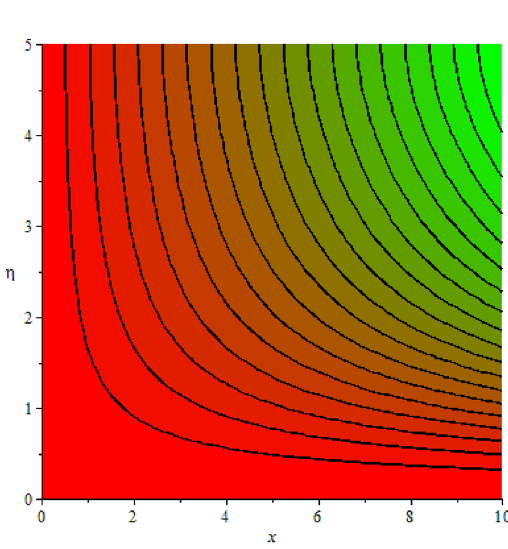
Figure 3. Stream lines when γ = 0.5 and K =